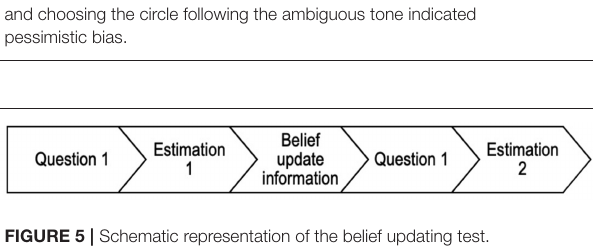
Belief Updating Index were calculated as the means from the respective